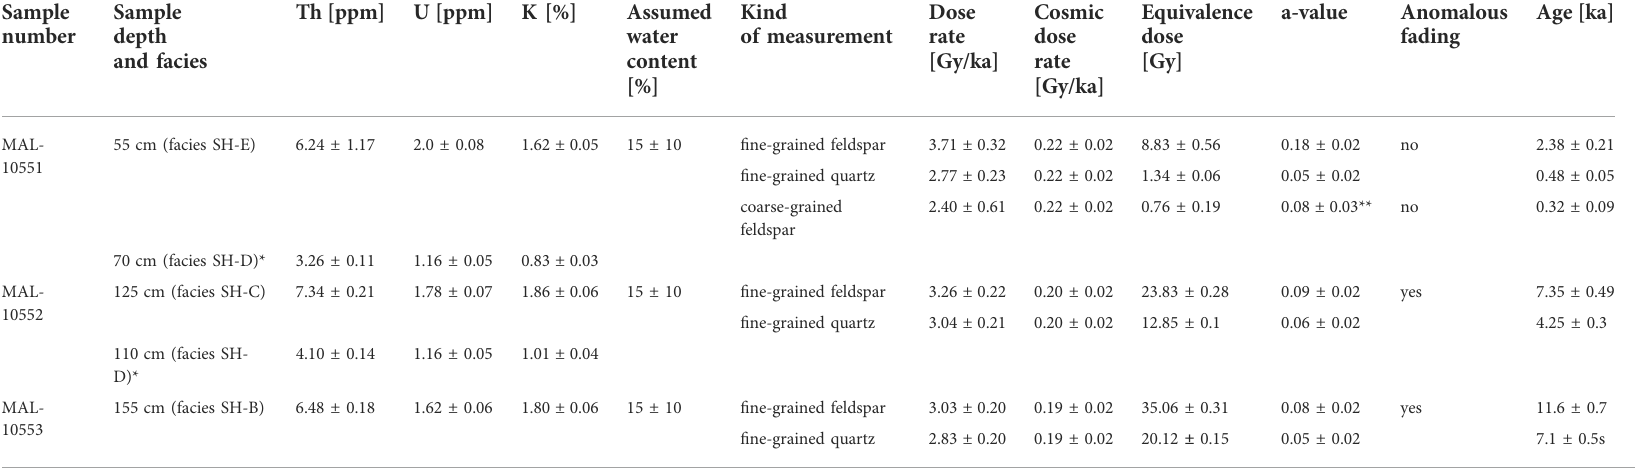
TABLE 1 Measurement parameters and results of luminescence dating from the